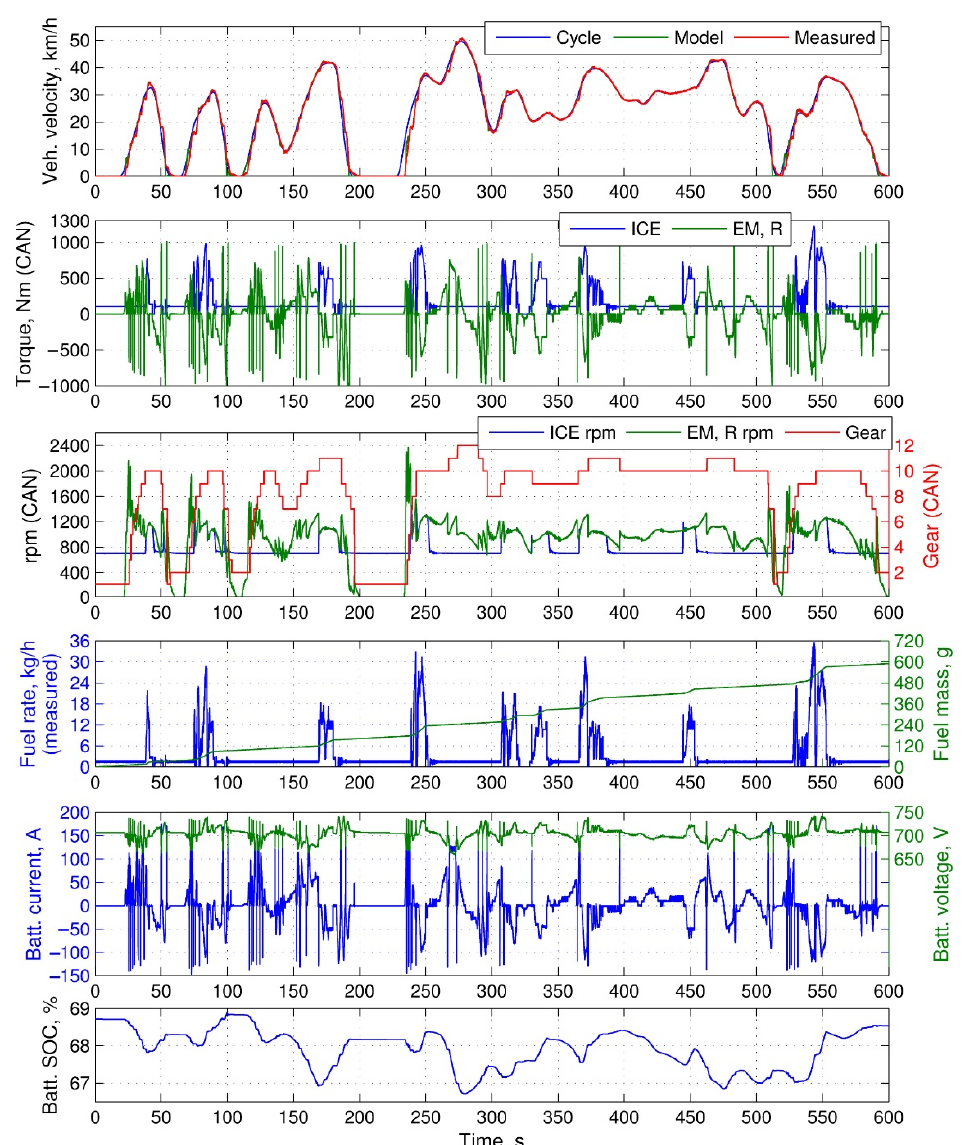
Figure 6. Example of CiL testing results simulating the hybrid powertrain operation in a driving cycle.